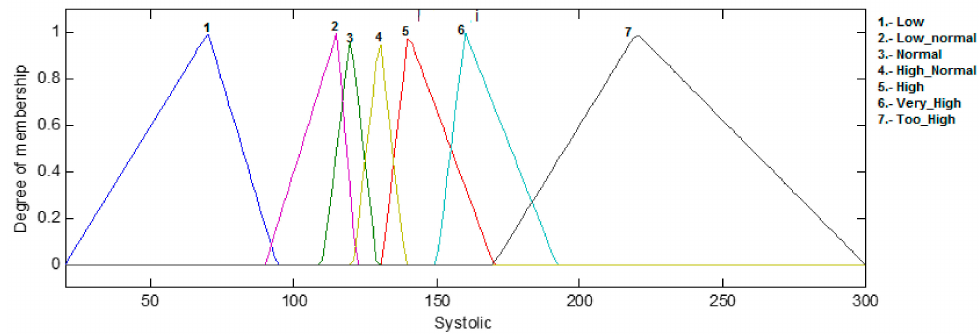
Figure 8. Systolic input for the fuzzy logic classifier